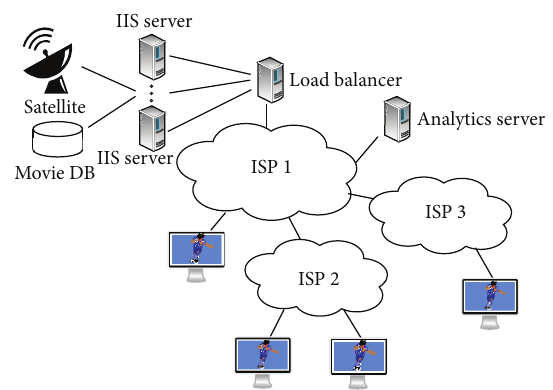
Figure 1: The Comoyo streaming infrastructure.